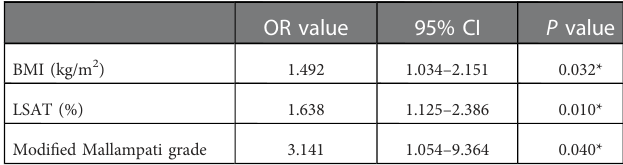
TABLE 3 Independent prediction variables for Δ